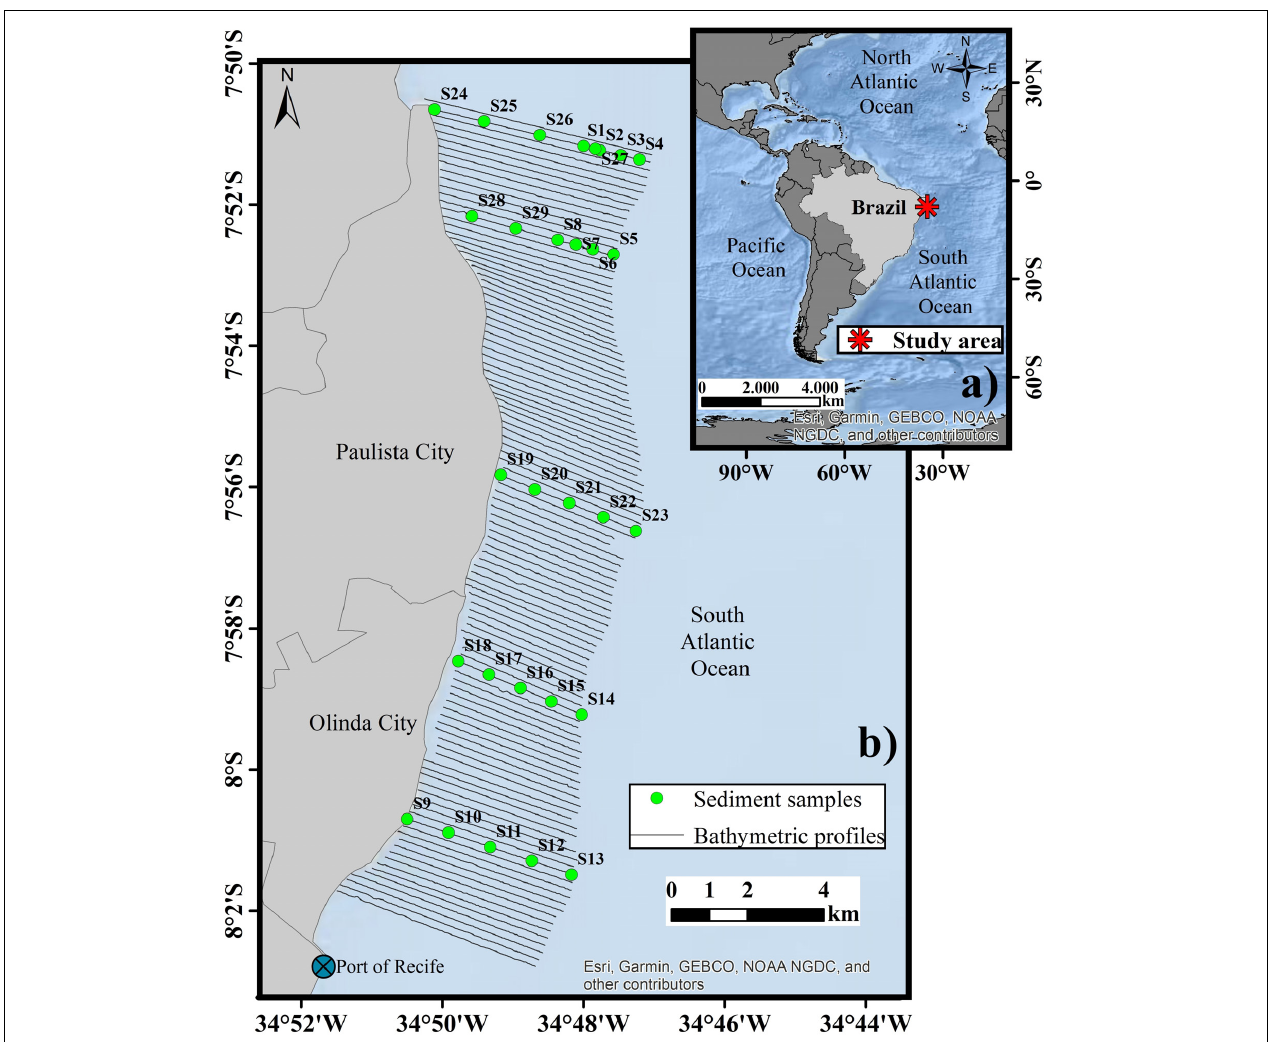
FIGURE 1 | (a) Location map of the study area; (b) Bathymetric profiles surveyed and sediment samples at the study